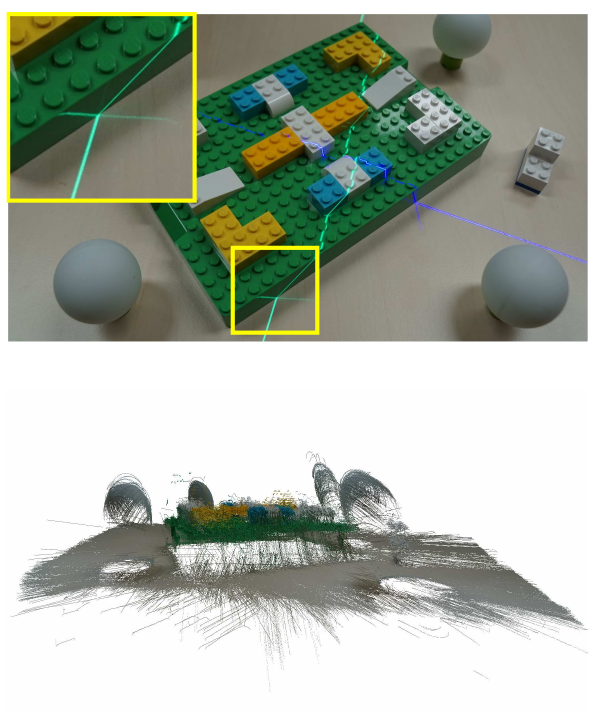
Figure 4: Reflections of the laser line due to glossy surfaces and resulting distorted point cloud